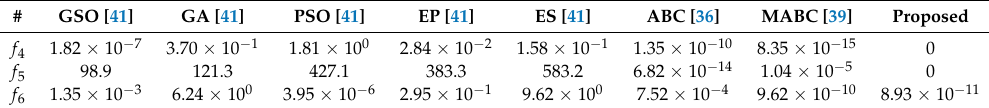
Table 3. Comparison of the obtained results by IABC with other algorithms for large-scale benchmark functions.